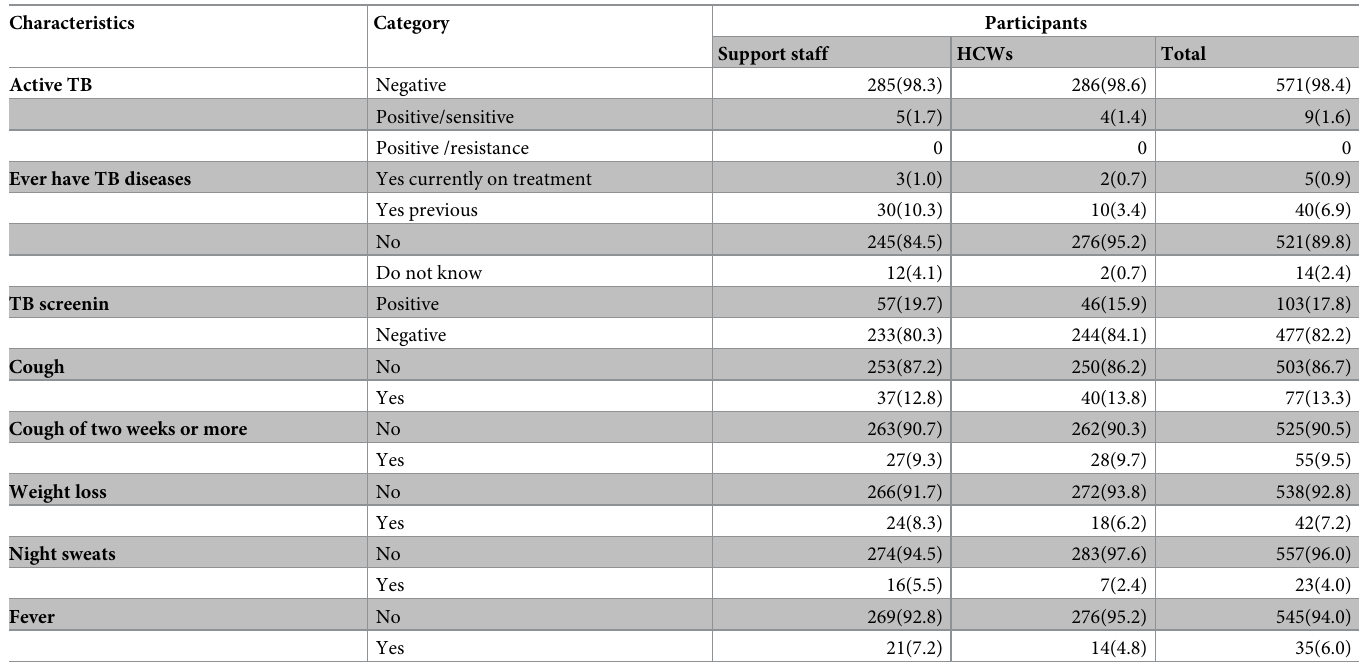
Table 3. TB diseases status and symptoms in Amhara region. Characteristics